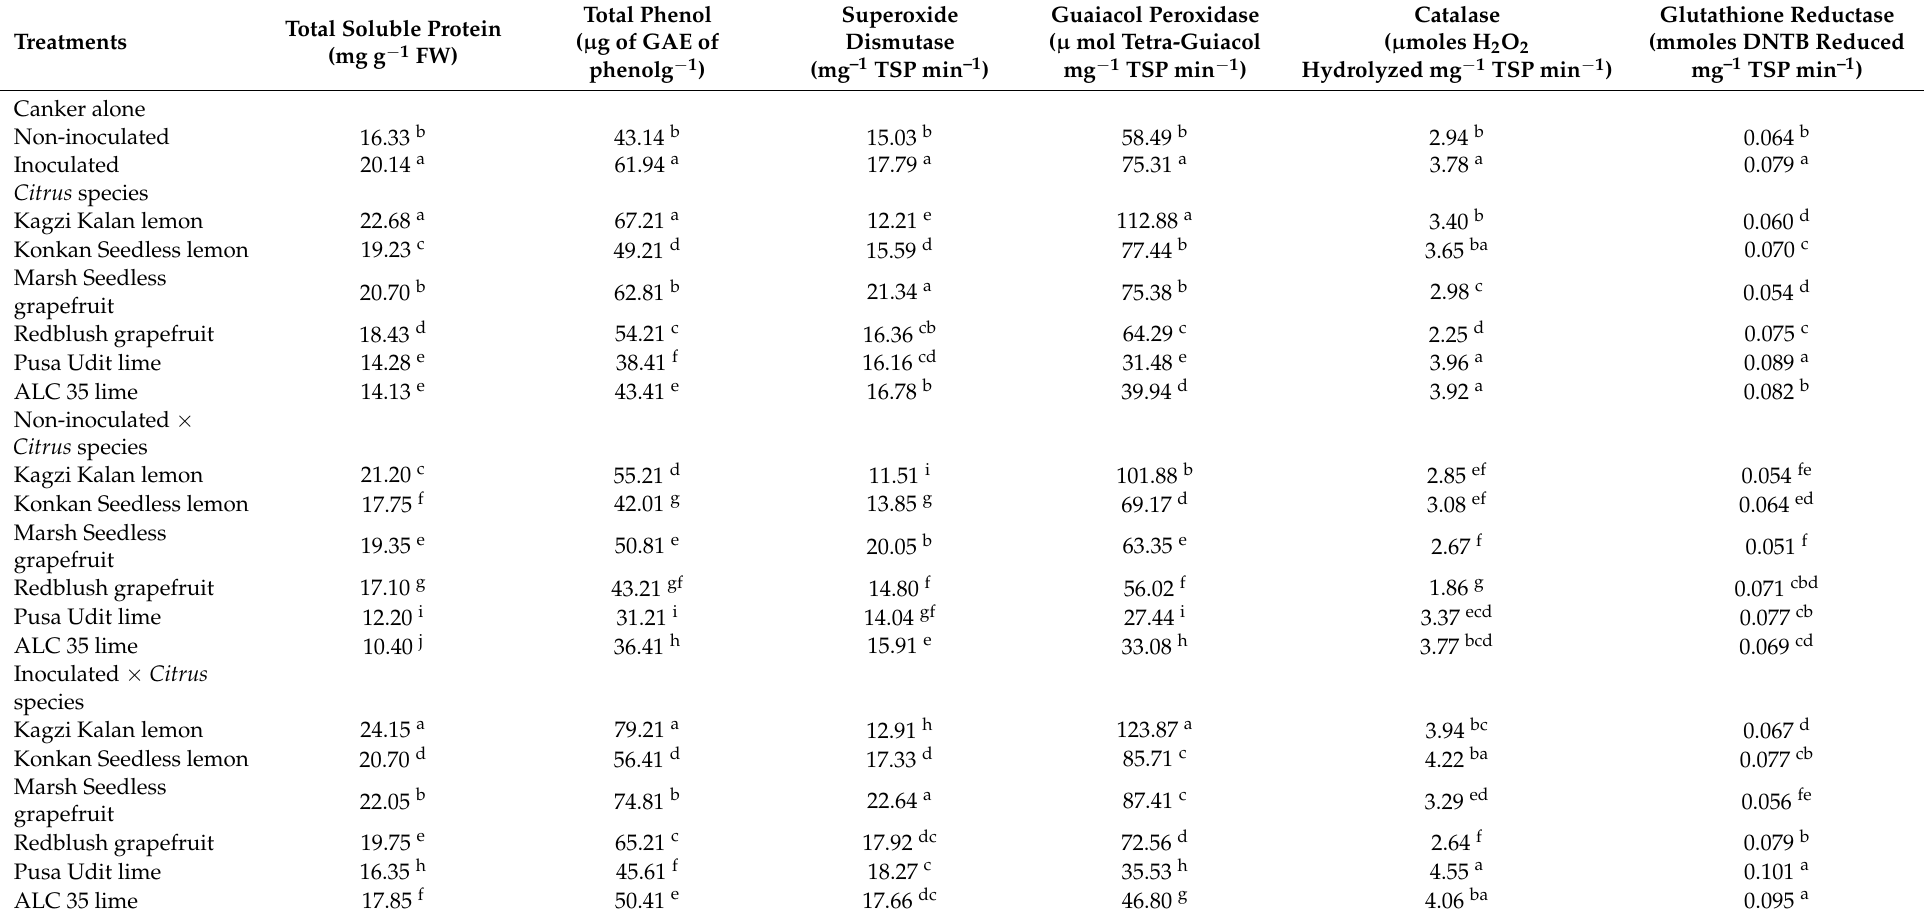
Table 3. Effect of X. citri pv. citri inoculation on the contents of soluble protein, phenol, and the activity of antioxidant enzymes of citrus